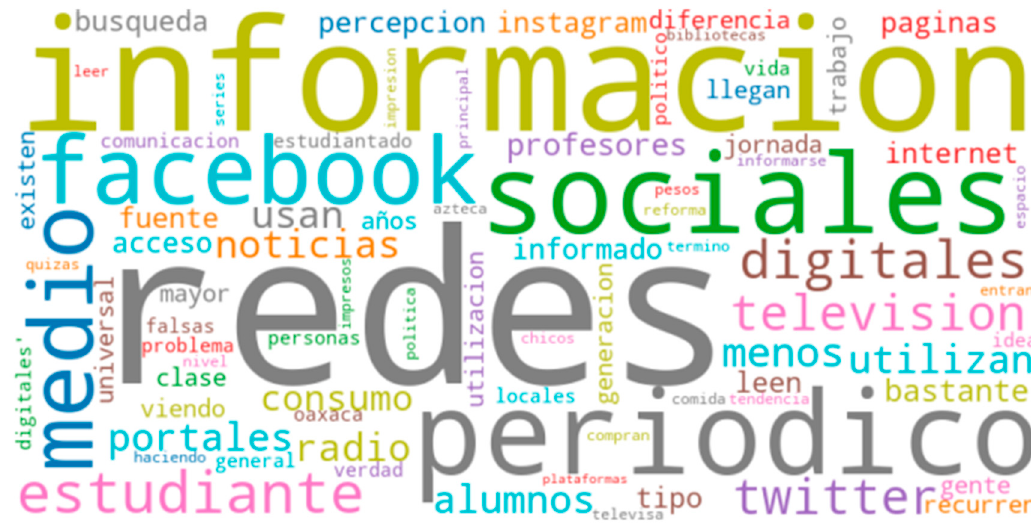
Figure 2. Frequency of words about media consumption.